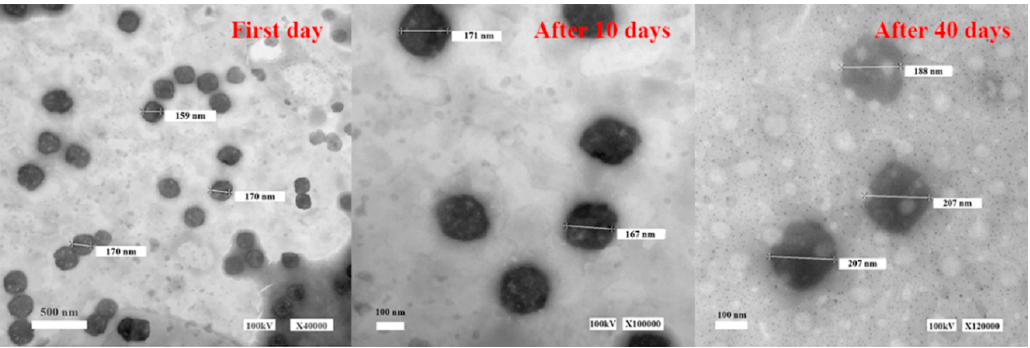
Figure 2. Particle size distribution ( A ) initial vesicle; ( B ) in 10 days; ( C ) in 40 days ( n = 3).